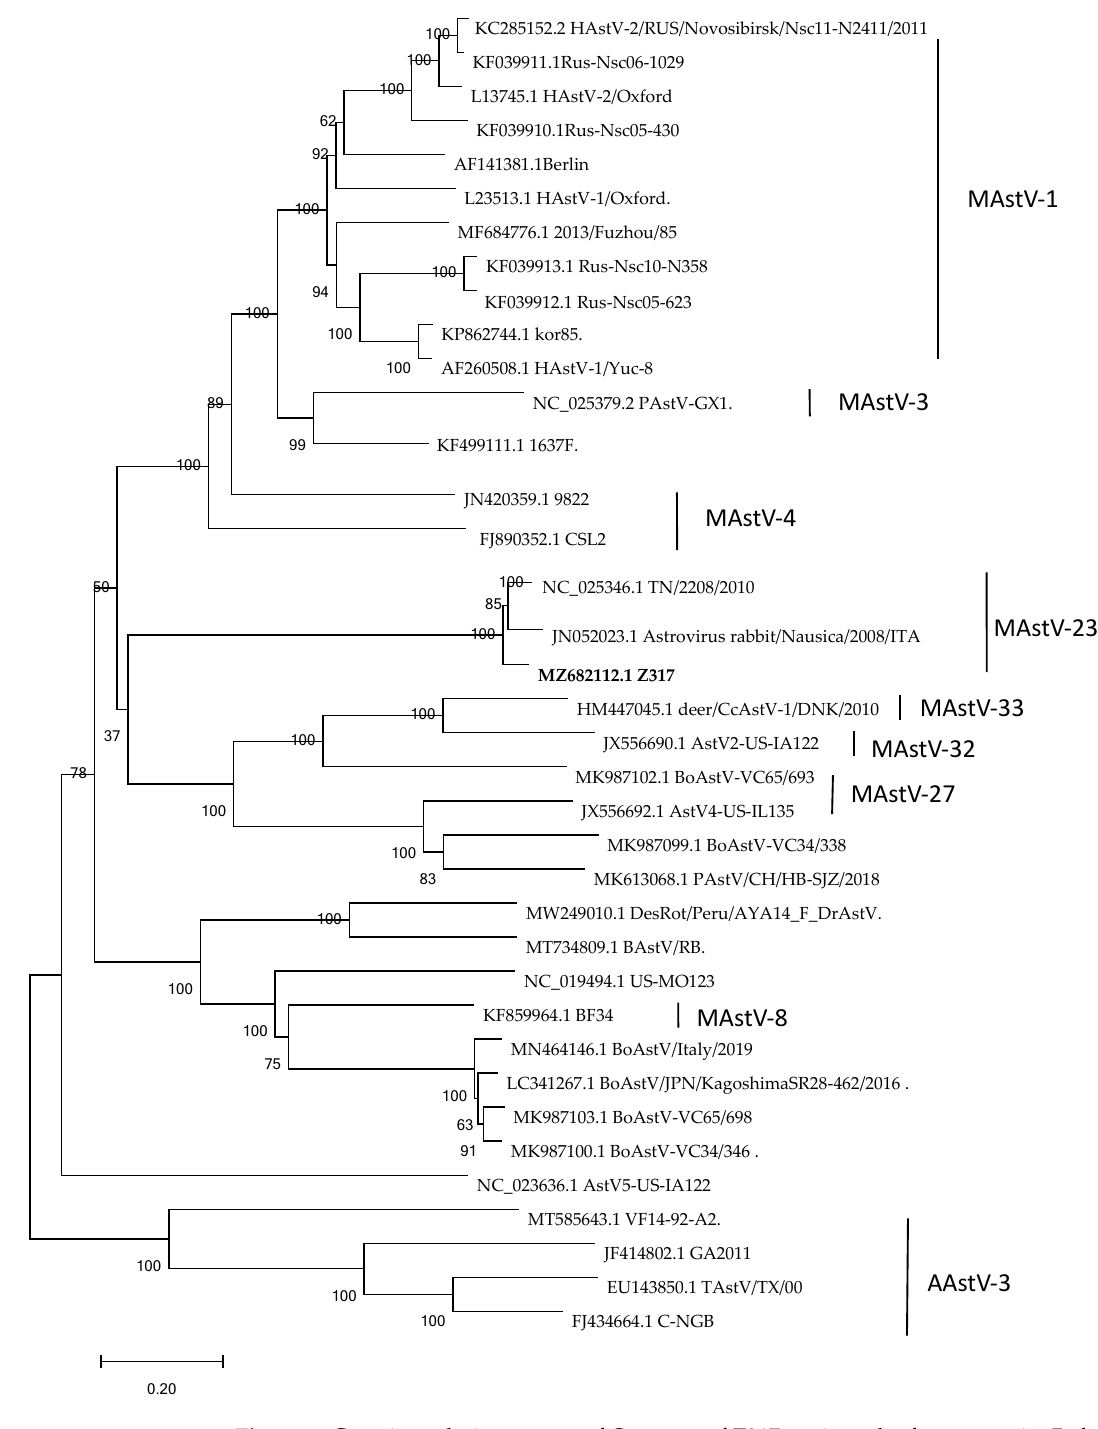
Figure 2. Genetic evolutionary tree of Cap gene of Z317 strain and reference strain. Reference strains from Genbank database. The phylogenetic tree was constructed by MEGA 7.0 using the Maximum Likelihood Method (1000 bootstrap). Bootstrap values > 60% were considered to be